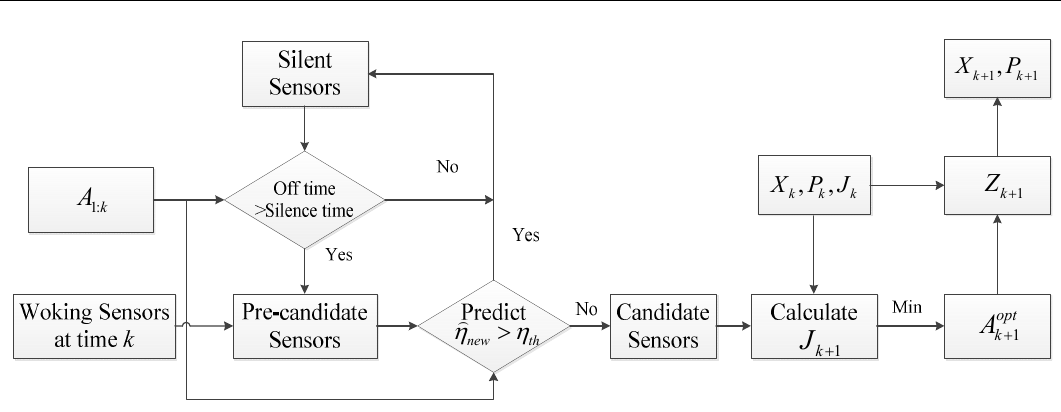
Figure 5 . Process of multi-sensor scheduling at time k. Figure 5. Process of multi-sensor scheduling at time